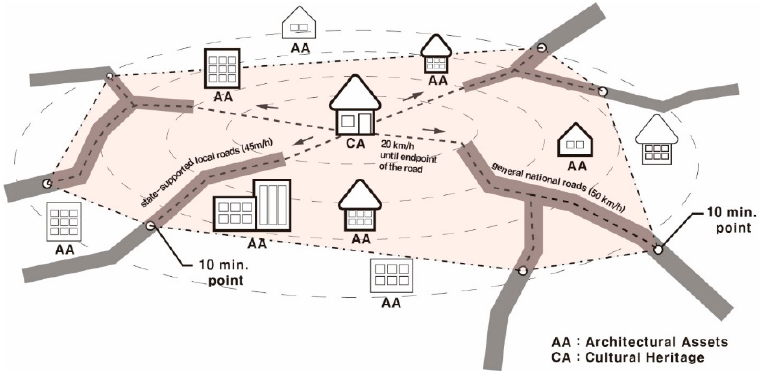
Figure 4. Concept image of extraction of the range of candidates for architectural assets linked to cultural heritage. cultural